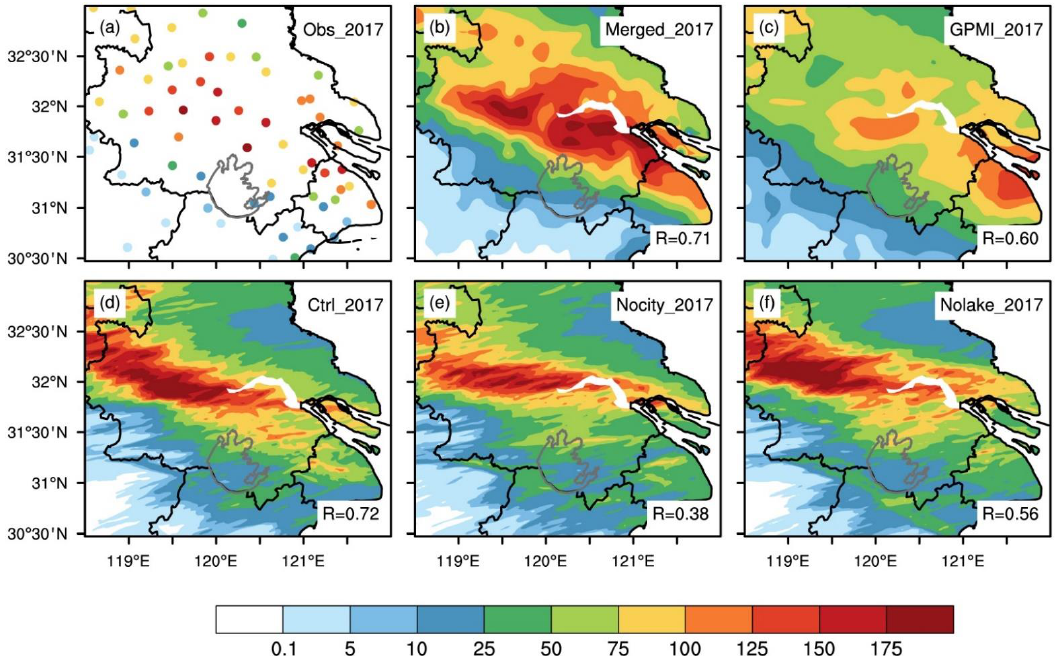
Figure 2. The distributions of the daily precipitation (unit: mm) for ( a ) the station observations, ( b ) the Merged, ( c ) the GPMI and ( d – f ) three simulations (control, Nocity, and Nolake) for EP925. The right-bottom R denotes the spatial correlation coefficients between the observation and the corre- sponding dataset.